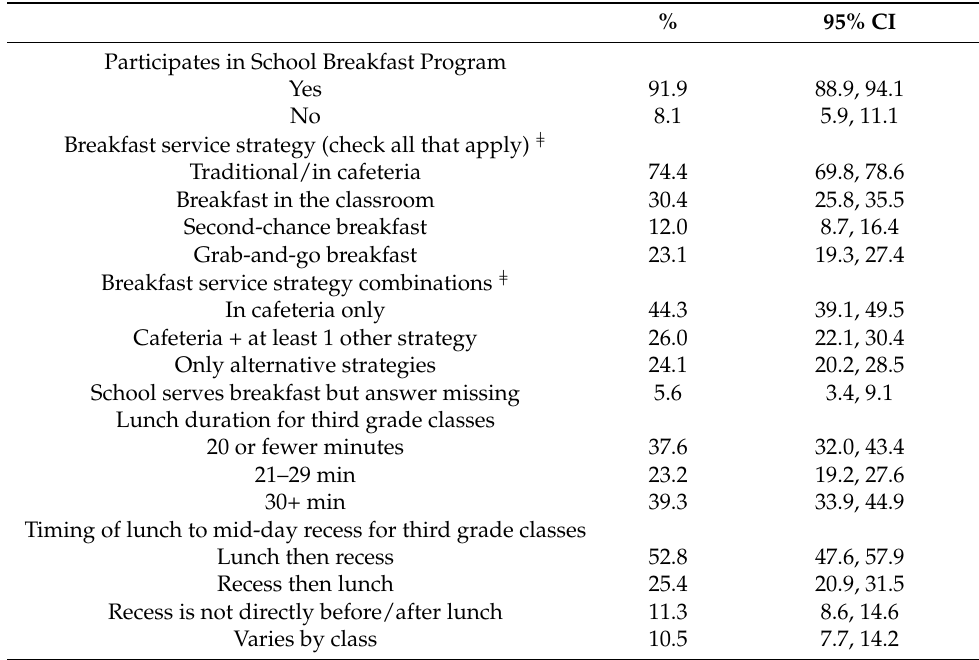
Table 2. Descriptive statistics for breakfast and lunch practices at 542 US public elementary schools,